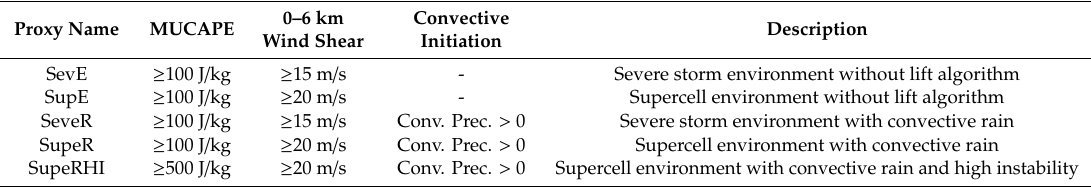
Table 1. Proxies used in the study.